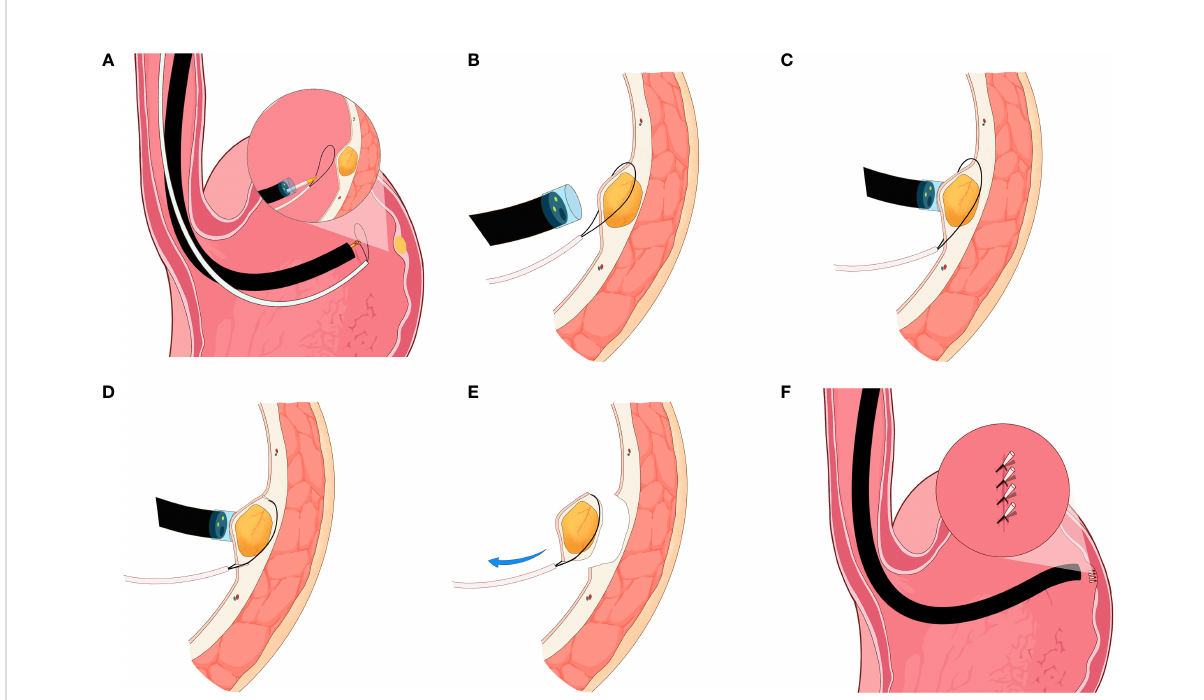
FIGURE 1 Infographics of snare-assisted endoscopic resection technique. (A) Endoscope attached with snare at the tip was inserted into the gastric cavity and view of the small submucosal gastric tumors. (B) Snare ligation around the base of the tumor. (C) Suction of the tumor into the transparent cap and snare tightening around the base of the tumor. (D) Complete resection of the small submucosal gastric tumors using snare assistance. (E) Resected tumor and view of the lesion resection site. (F) Endoscopic clipping to close the lesion resection